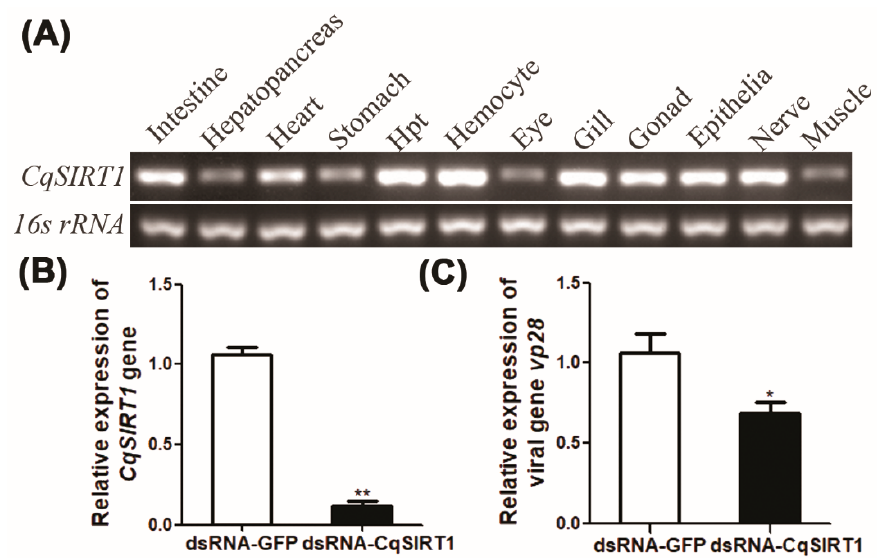
Figure 2. Tissue distribution and the effect of Cq SIRT1 on WSSV gene transcription. ( A ) The relative expression of the CqSIRT1 gene in different tissues from C. quadricarinatus as shown by semi-quantitative RT-PCR. The 16s ribosome RNA served as the inter-control. ( B ) Gene knockdown efficiency of Cq SIRT1 in Hpt cells. The relative expression of Cq SIRT1 was determined in Hpt cells transfected with Cq SIRT1 dsRNA followed by WSSV infection. The GFP dsRNA was used as negative control. ( C ) The relative expression of late viral gene vp28 in Cq SIRT1-silenced Hpt cells. The relative expression of vp28 was measured in Hpt cells transfected with Cq SIRT1 dsRNA followed by WSSV infection. The GFP dsRNA served as negative control. These experiments were performed in biological triplicates (*, p < 0.05, **, p < 0.01).